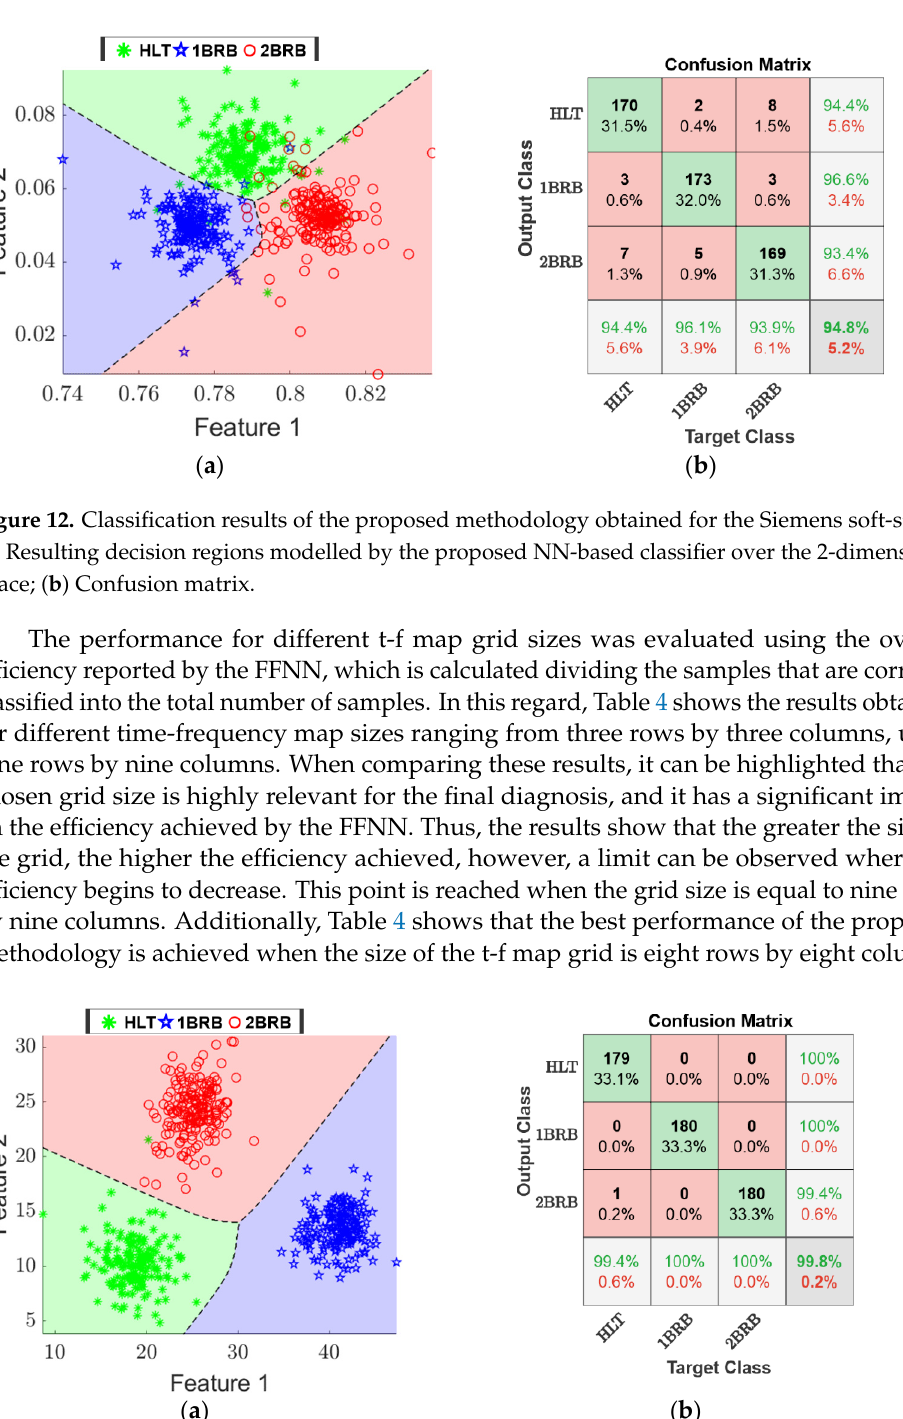
Figure 14. Classification results of the proposed methodology obtained for the Omron soft-starter. ( a ) Resulting decision regions modelled by the proposed NN-based classifier over the 2-dimensional space; ( b ) Confusion matrix.